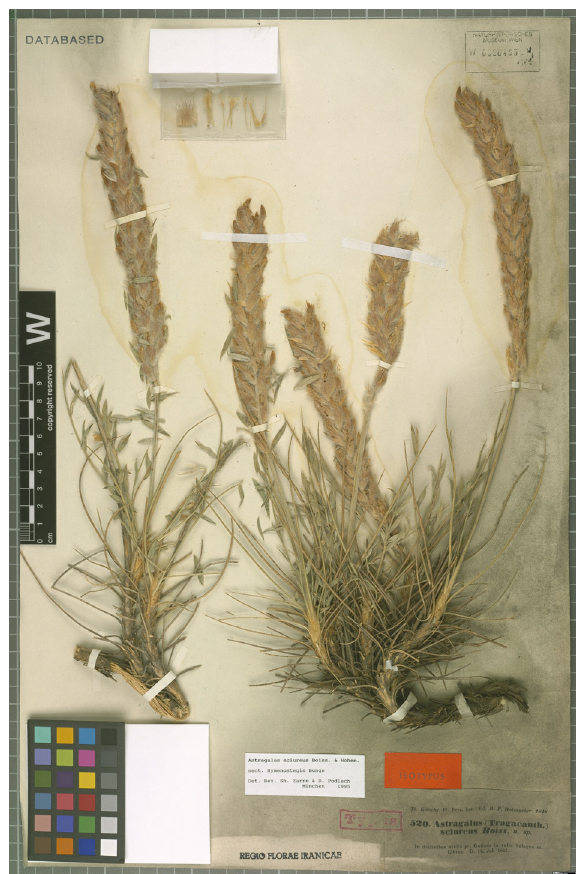
Fig 2. Isotype of Astragalus sciureus (digital barcode in W herbarium: W 0026465).